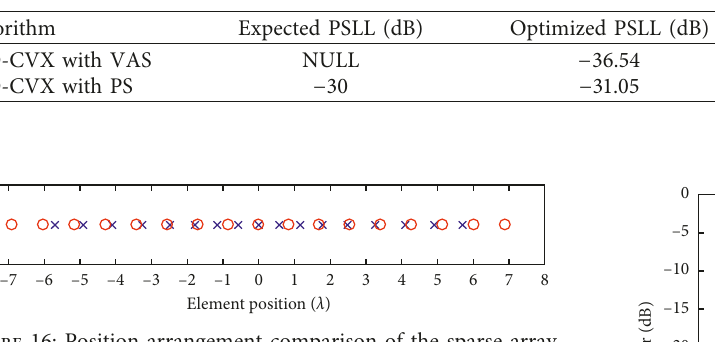
Figure 15: Sideband level comparison of the time-modulated sparse array with equal amplitude and phase excitation. (a) Comparison of first side band level. (b) Comparison of second side band level. Table 6: Sideband level comparison of two time modulation modes.